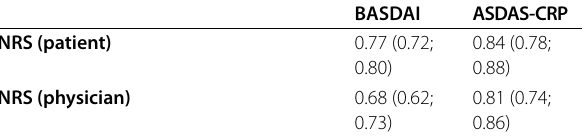
Table 4 Correlation coefficient (95%CI) of patients and physicians’ perceptions of disease activity with the PRO.